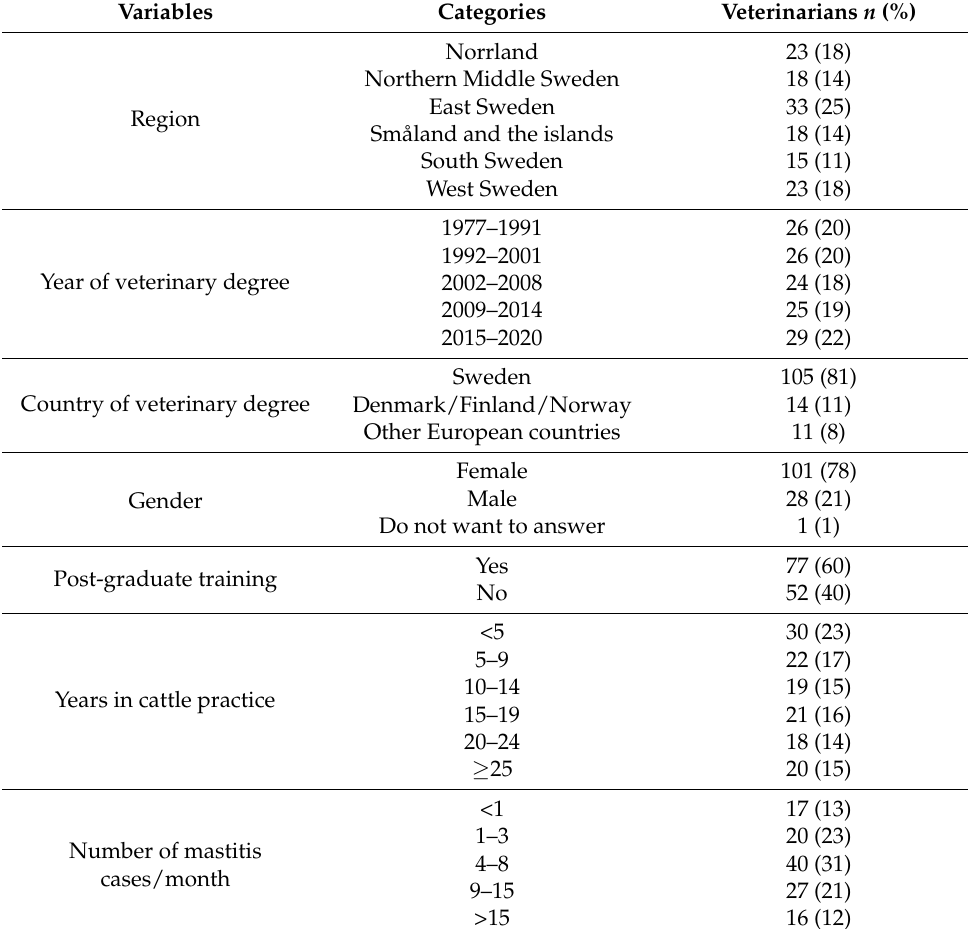
Table 2. Distribution of veterinarians ( n = 130) participating in a web-based questionnaire on advice on drying-off and dry period among veterinary